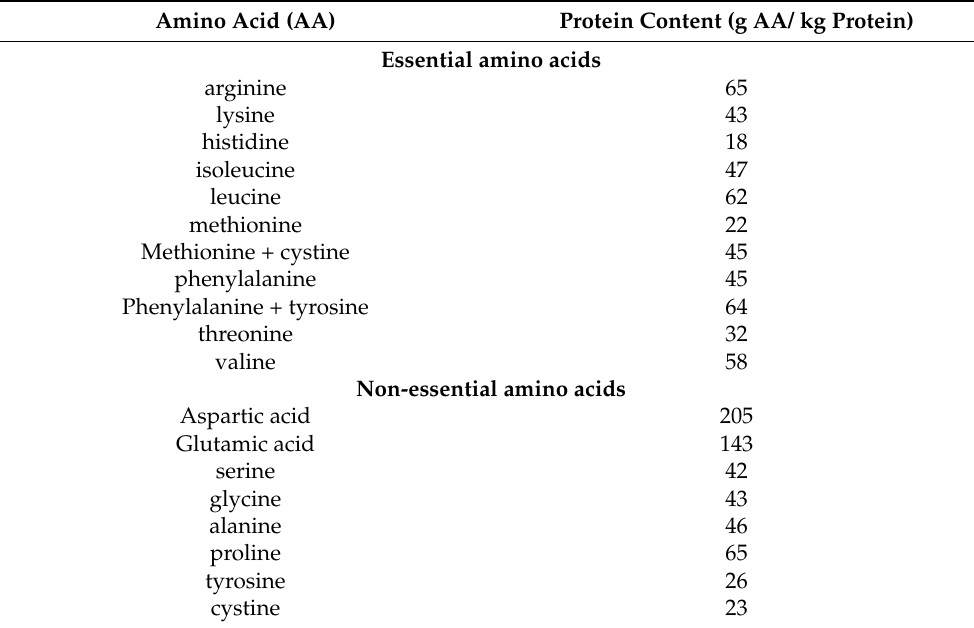
Table 6. Aminogram of acorn (Quercus rotundifolia ) kernel protein. According to [202]. Amino Acid (AA) Protein Content (g AA/ kg Protein)